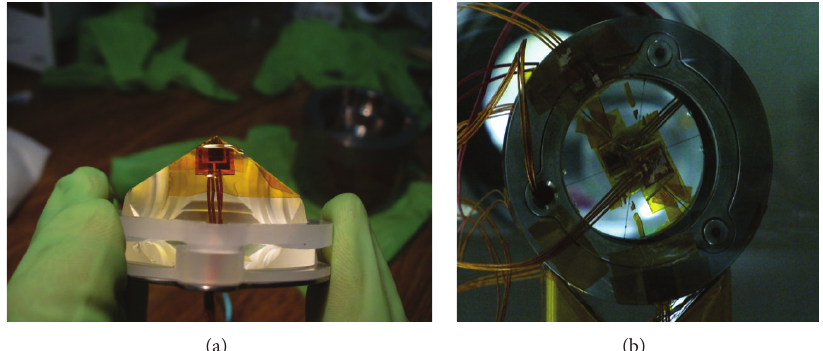
Figure 7: LARES cube corner reflector. PT100 glued close to the apex of CCR (a) and on the front face (b).